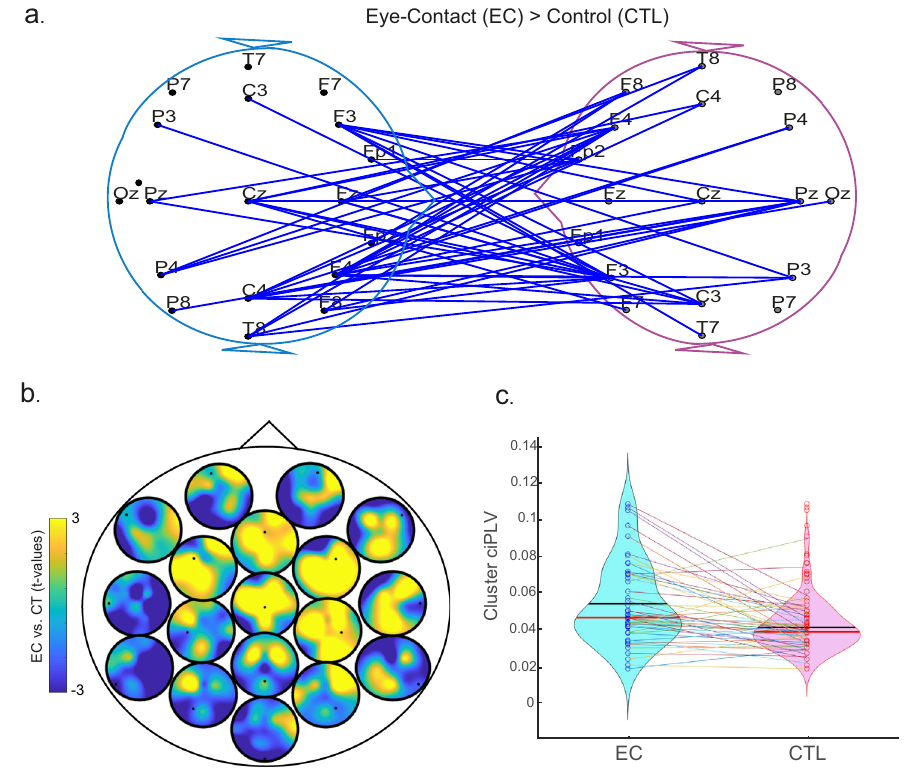
Fig. 2 Interbrain synchronization during eye contact. Gamma-band brain synchronization (ciPLV) within pairs during eye contact (EC) vs. control condition (CTL). a Blue lines represent electrode pairs with signi fi cantly higher gamma synchronization in EC compared to CTL. The signi fi cant cluster shows widespread connections between brains, especially distributed on the right hemisphere. b Heads-in-head representation of the difference in gamma synchronization during eye contact compared to the control task for the inter-brain connections. Each circle represents the scalp topography of the connections with the channel highlighted inside as a black dot. The colours represent differences in phase synchronization between that channel (dot) and the other person ’ s scalp during eye contact expressed as a t - value of the contrast through the cluster permutation analysis. Yellow colours represent higher t-values for synchronization during eye-contact compared to control. c Violin plots showing the mean (red) and median (black) gamma synchronization for the cluster of interbrain connections (highlighted in blue in a) during eye contact and during the control task. Each datapoint is displayed in the fi gure and the lines show the changes for each pair — from eye contact (EC) to control